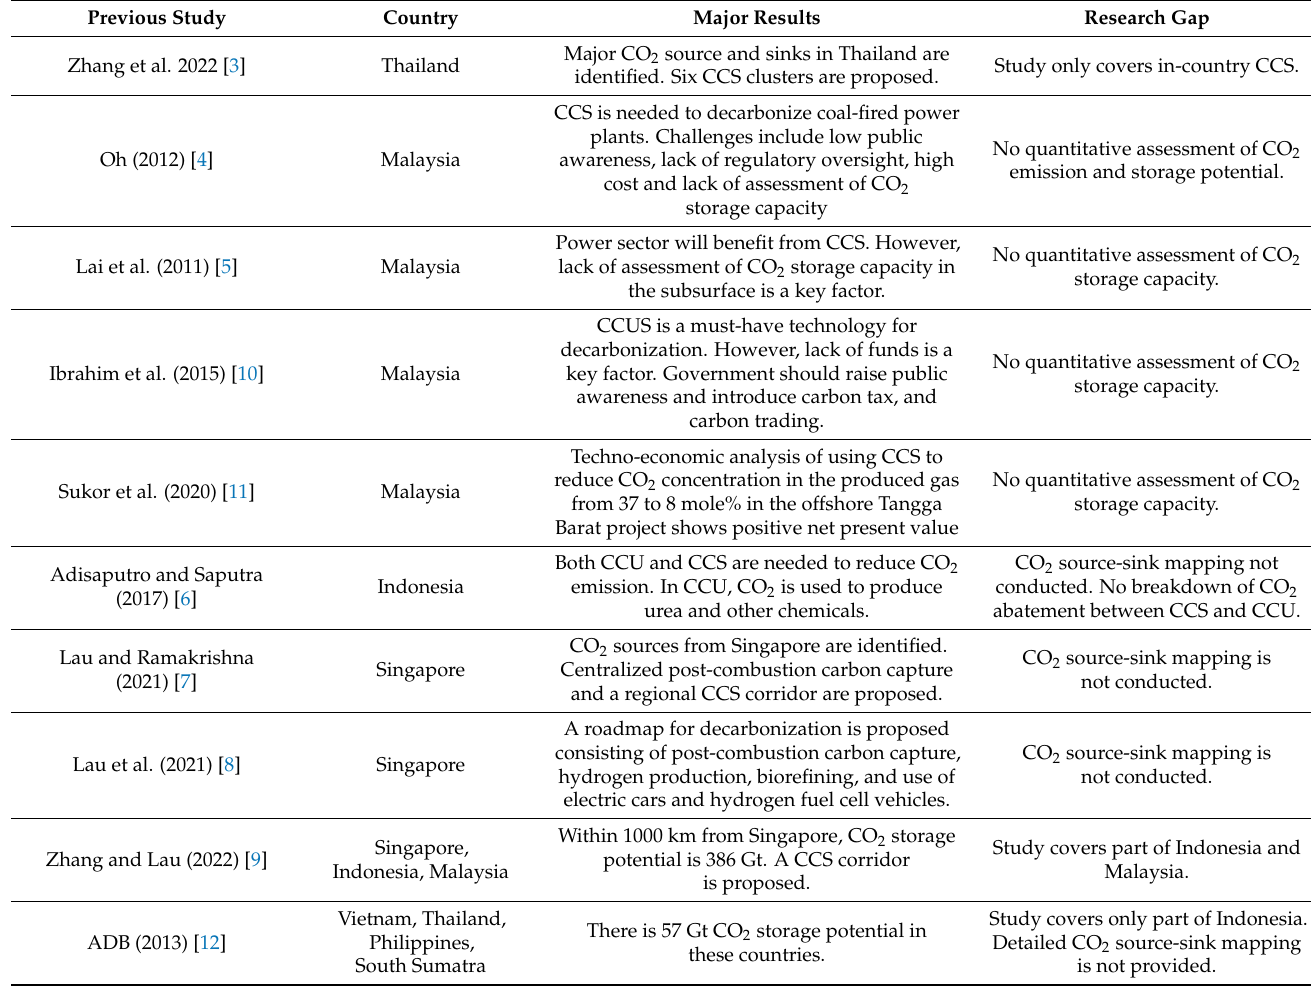
Table 1. Previous studies on CCS in Southeast Asia.